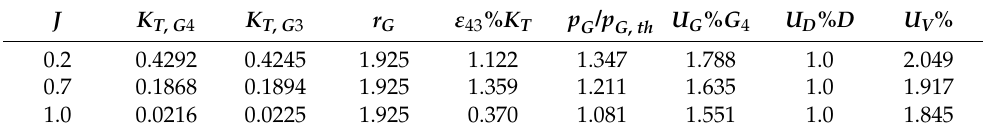
Table 4. Verification for the thrust coefficient for J = 0.2, 0.7, 1, grids G4, G3.